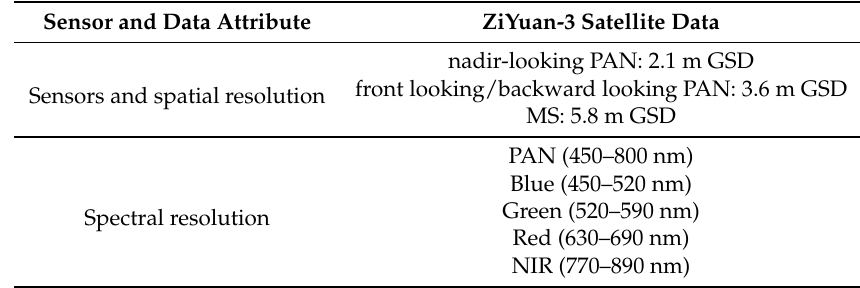
Table 1. Characteristics of ZiYuan-3 data [12]. PAN: panchromatic; GSD: ground spatial distance; MS: multispectral; NIR: